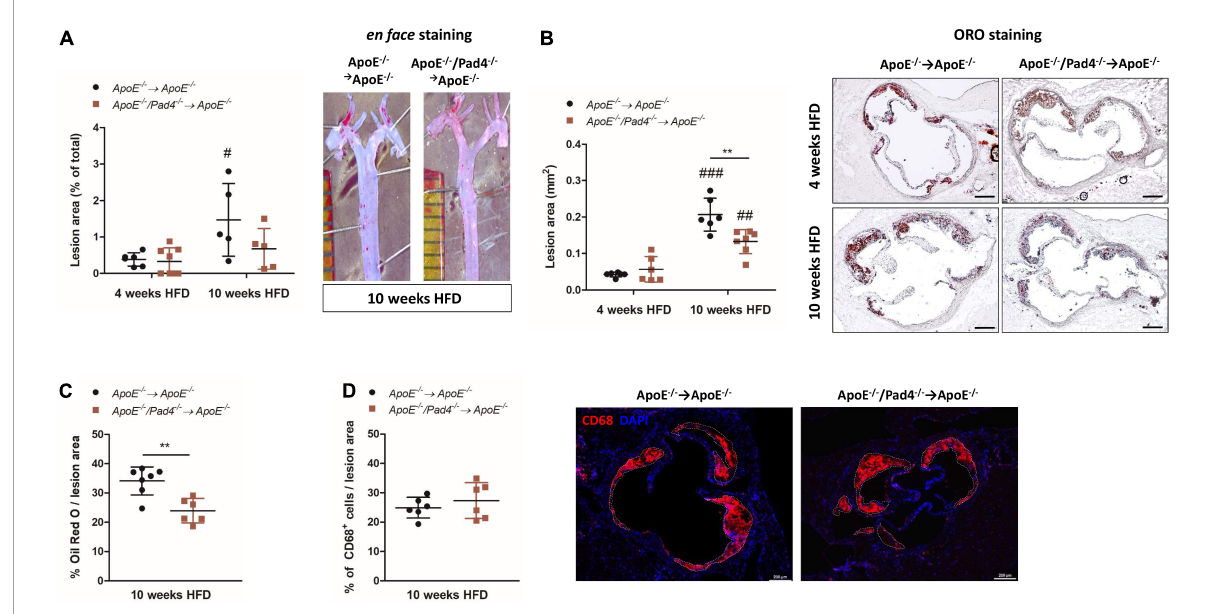
FIGURE2 PAD4 deficiency diminishes lesion size and lipid accumulation. (A) Quantification of lesion area of en face -stained aortas after 4 and 10 weeks of high-fat diet (HFD). Representative ORO-stained aortas after 10 weeks are depicted. n = 5–8/group. (B) Quantification of lesion area in ORO-stained aortic root sections. Representative images for each time point and each experimental group are depicted. Scale bar: 200 µ m. n = 6–7/group. (C) Quantification of ORO-positive areas in aortic roots. n = 6–7/group. (D) Quantification of CD68-positive cells (inflammatory macrophages/monocytes) in aortic roots of mice fed a HFD for 10 weeks. Representative images are depicted. Scale bar: 200 µ m. n = 6/group. # p < 0.05, ## p < 0.01, ### p < 0.001 vs. 4 weeks HFD; ** p <